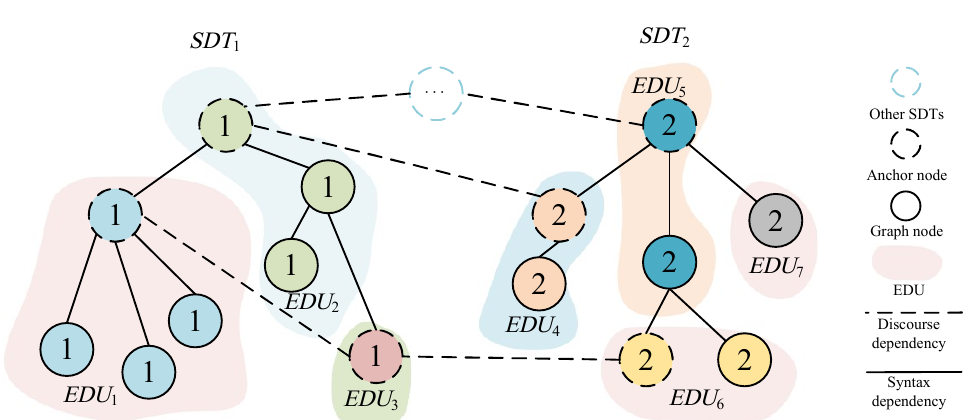
Fig. 4 Example of the SDT-forest connected by the syntax and discourse dependencies. Two SDTs are plotted and the others are omitted. The coloured areas depict the EDUs in the corresponding SDT. Each EDU has an anchor node (circle with dashed lines), which is a relative root node in the subtree (coloured